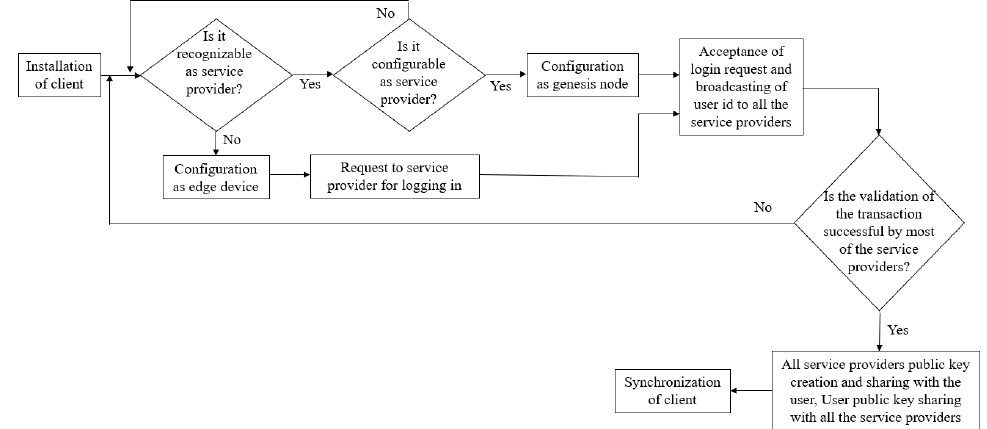
Figure 5. Work flow diagram of node initiation in the proposed